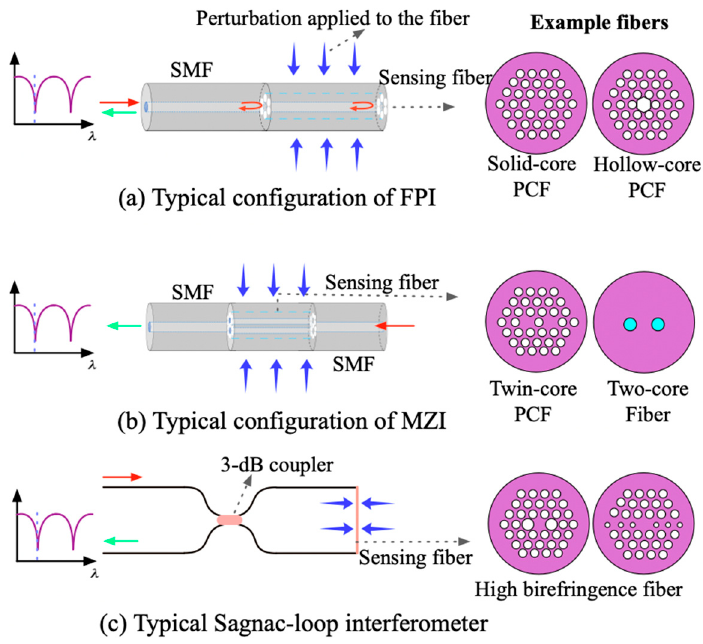
Figure 4. Typical configurations of FPI, MZI, and SI interferometers.